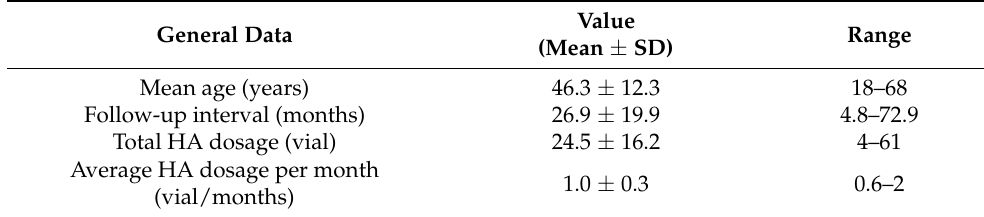
Table 1. Basic characteristics of patient (n = 35) who underwent intravesical hyaluronic acid instilla- tion therapy after cystoscopy.